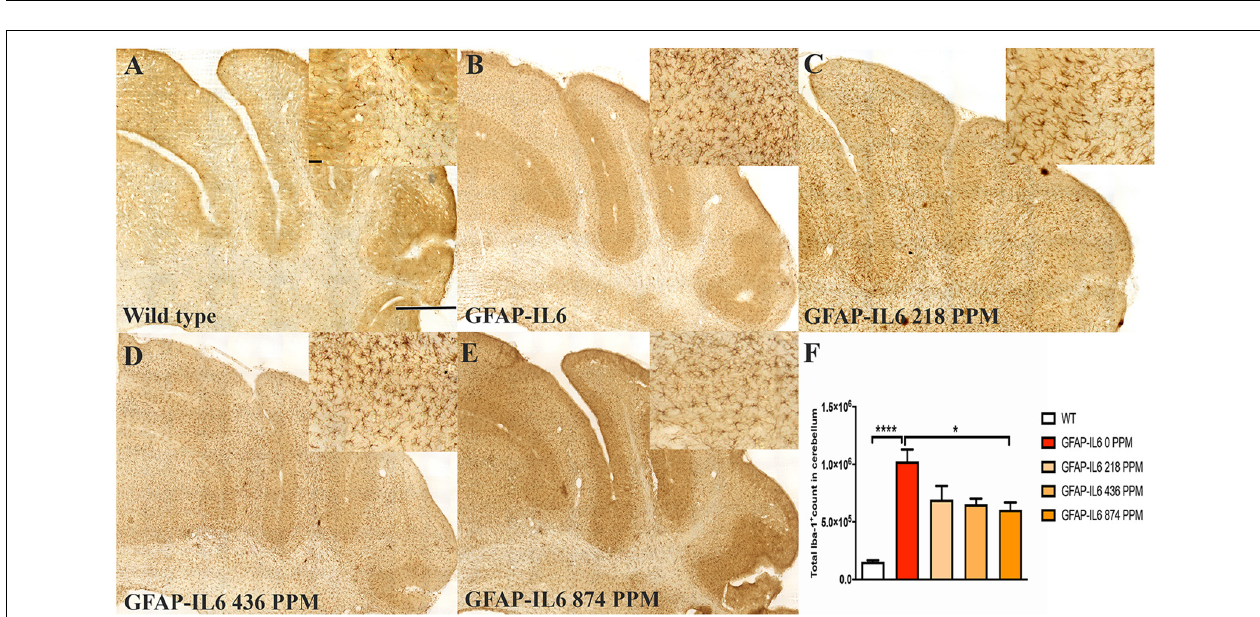
FIGURE 1 | MC decreased the number of Iba-1 + microglia in the hippocampus of GFAP-IL6 mice. (A–E) Representative photomicrographs of immunohistochemical staining for the microglia (Iba-1 + cells) of the hippocampus. (Magnification 10x objective field, scale bar = 500 µ m and 100 µ m in inserts). Images are representative of at least six animals per group ( n = 6). (F) Graphical representation of total Iba-1+ count in the hippocampus. The graph represents the mean ± SEM and significant differences were determined using one-way analysis of variance (ANOVA). Significance = **** p < 0.0001, * p < 0.05.